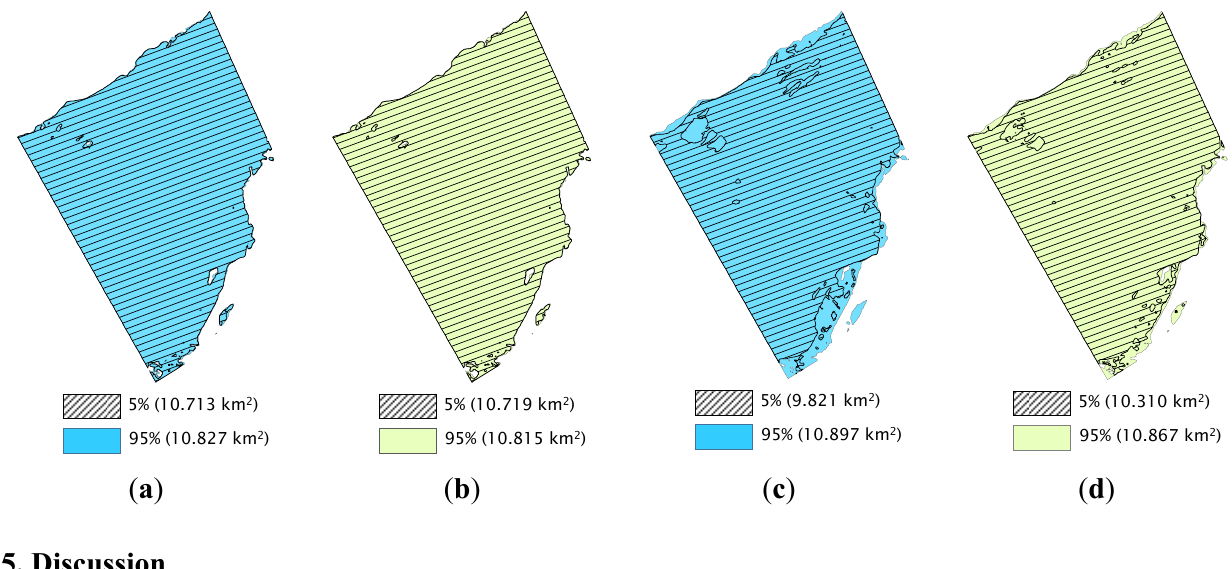
Figure 9. Inundation areas for Seymour Reach. ( a ) Inundation area by taking the top 20% of the F likelihood measures; ( b ) Inundation area by taking the top 20% of the E likelihood measures; ( c ) Inundation area by taking the top 100% of the F likelihood measures; ( d ) Inundation area by taking the top 100% of the E likelihood measure; where, 5 and 95 indicate the lower 5% and the higher 95% inundation areas,